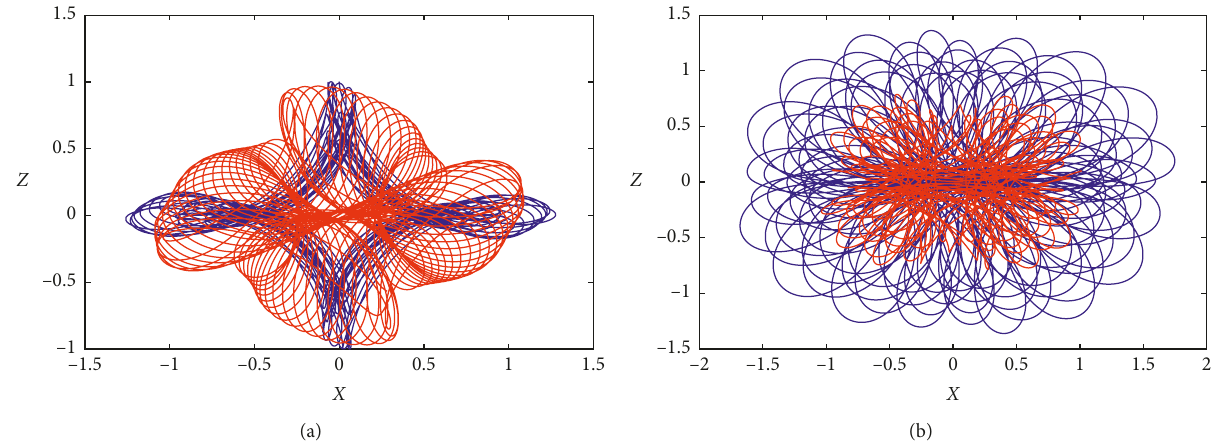
Figure 10: Phase portrait of system (6) with different circuit parameters (a) c